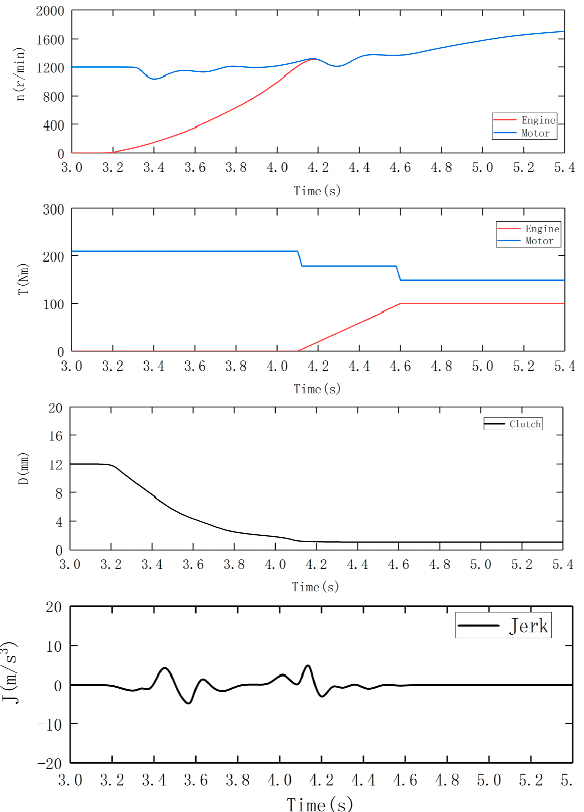
Energies 2019 , 12 , x FOR PEER REVIEW